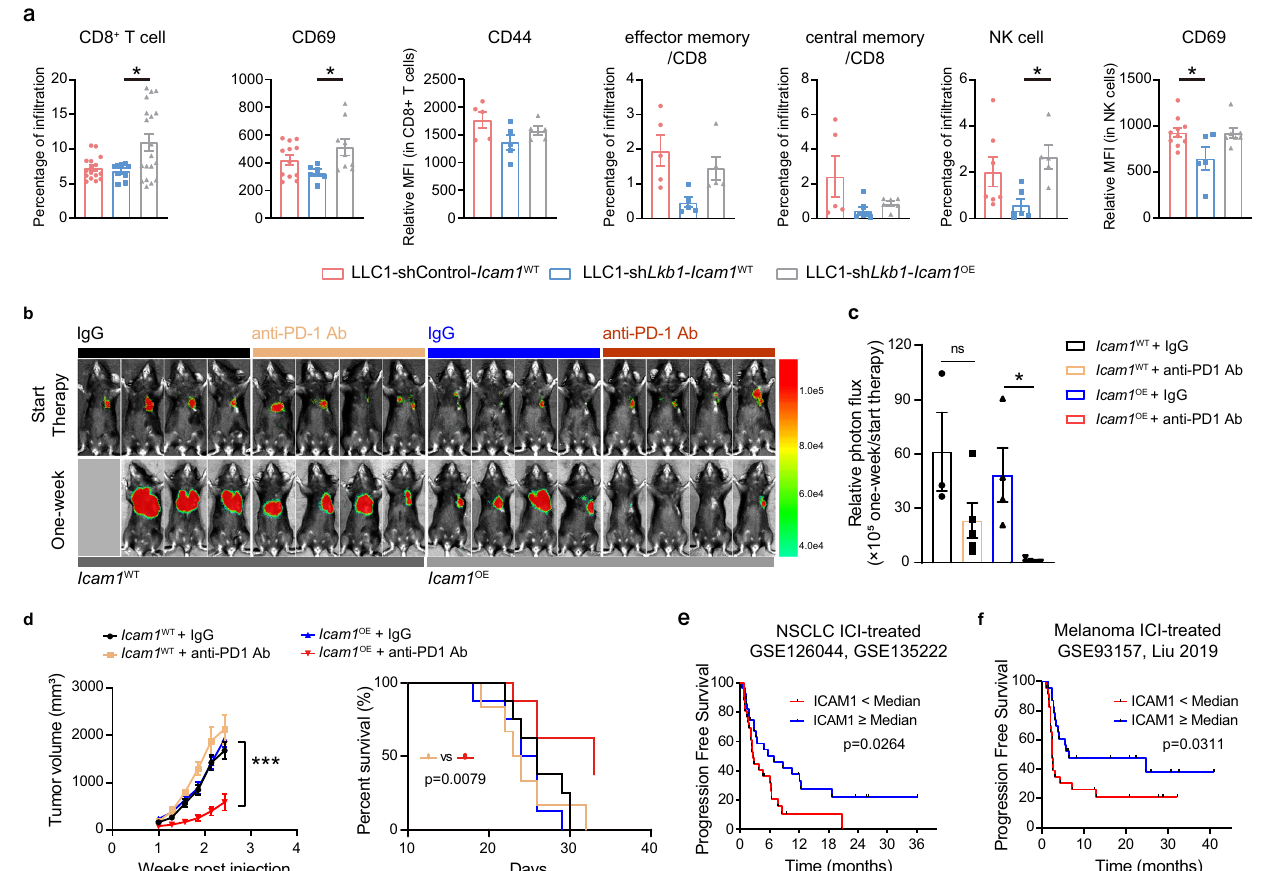
Fig. 4 | ICAM1 overexpression reactivated the TME and sensitized anti-PD-1 immunotherapy in Lkb1 de fi cient lung tumors. a Total CD8 + T cells relative to CD45 + cellsintumortissue,relativemean fl uorescenceintensity(MFI)ofCD69and CD44 on CD8 + T cells, percentage of CD62L + CD44 + (central memory T cells) and CD62L − CD44 + (effectormemoryTcells)inCD8 + Tcells,andtotalNKcellsrelativeto CD45 + cellsintumortissueandrelativeMFIofCD69onNKcellsfrommicebearing LLC1 tumors (LLC1-shControl- Icam1 WT , LLC1-sh Lkb1 - Icam1 WT , LLC1-sh Lkb1 - Icam1 OE ) wereanalyzedby fl owcytometry. n =1independentexperiment.CD8 + T-cell, n =13 in shControl- Icam1 WT , n =8 in sh Lkb1 - Icam1 WT , n =16 in sh Lkb1 - Icam1 OE ; * p =0.0193. CD69, n =12 in shControl- Icam1 WT , n =6 in sh Lkb1 - Icam1 WT , n =9 in sh Lkb1 - Icam1 OE ; * p =0.0436. CD44, n =5 samples in each group. Effector memory, n =5 samples in each group. Central memory, n =5 in shControl- Icam1 WT , n =7 in sh Lkb1 - Icam1 WT , n =6insh Lkb1 - Icam1 OE .NKcells, n =7inshControl- Icam1 WT ,n=6insh Lkb1 - Icam1 WT , n =5 in sh Lkb1 - Icam1 OE ; * p =0.0415. CD69, n =10 in shControl- Icam1 WT , n =5 in sh Lkb1 - Icam1 WT , n =7 in sh Lkb1 - Icam1 OE ; * p =0.0333. b LLC1-sh Lkb1 - Icam1 WT or LLC1-sh Lkb1 - Icam1 OE luc cells were injected into the left chest of mice and tumor formation was detected using a bioluminescence imager every week. Biolumines- cent images in mice bearing lung tumors treated with isotype and anti-PD-1.